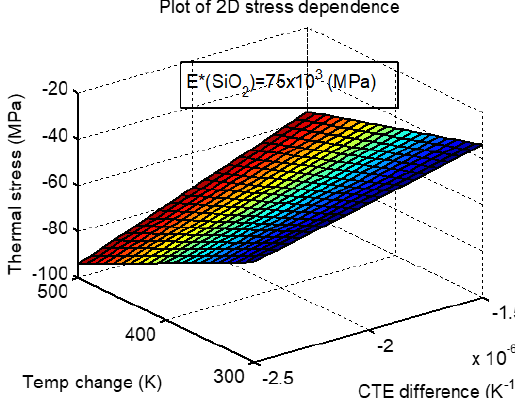
Figure 3. Numerical simulation results of the 2D thermal stress distribution with both the coefficient of thermal expansion (CTE) difference and temperature change in which the biaxial elastic modulus is taken as E *(SiO 2 ) = 75 × 10 3 (MPa).